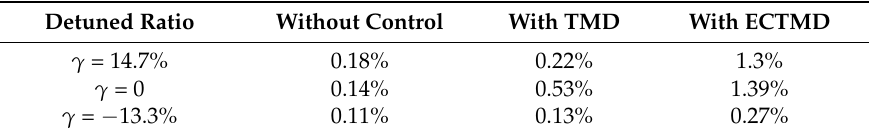
Table 5. Equivalent damping ratios in different situations.